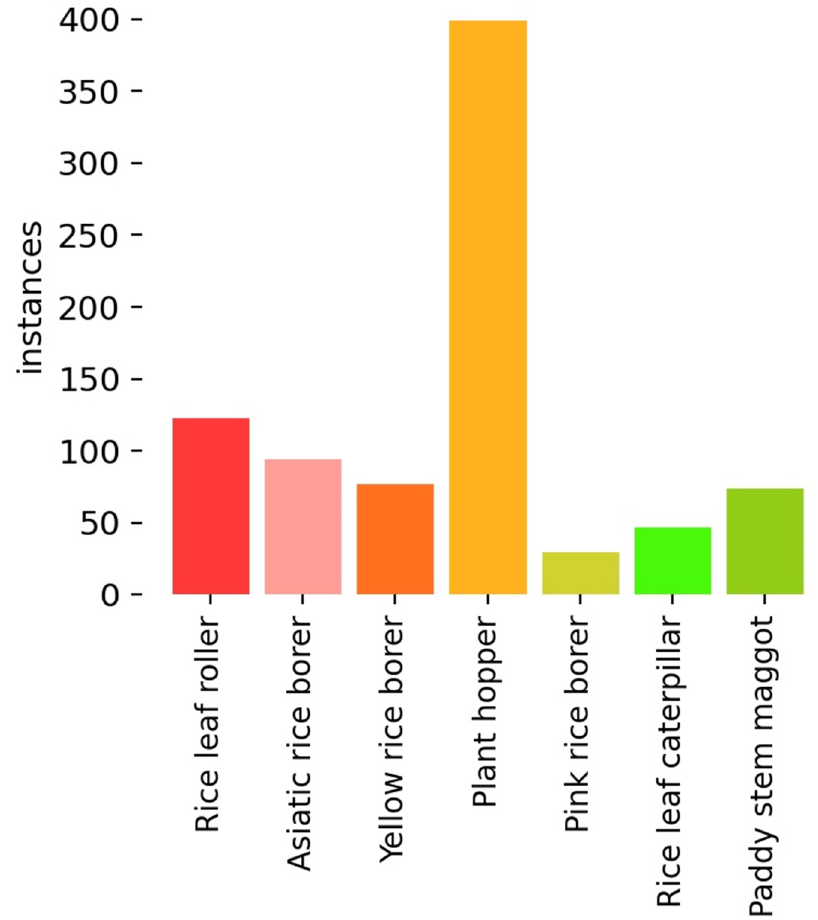
Figure 2. The number of labels of each category.